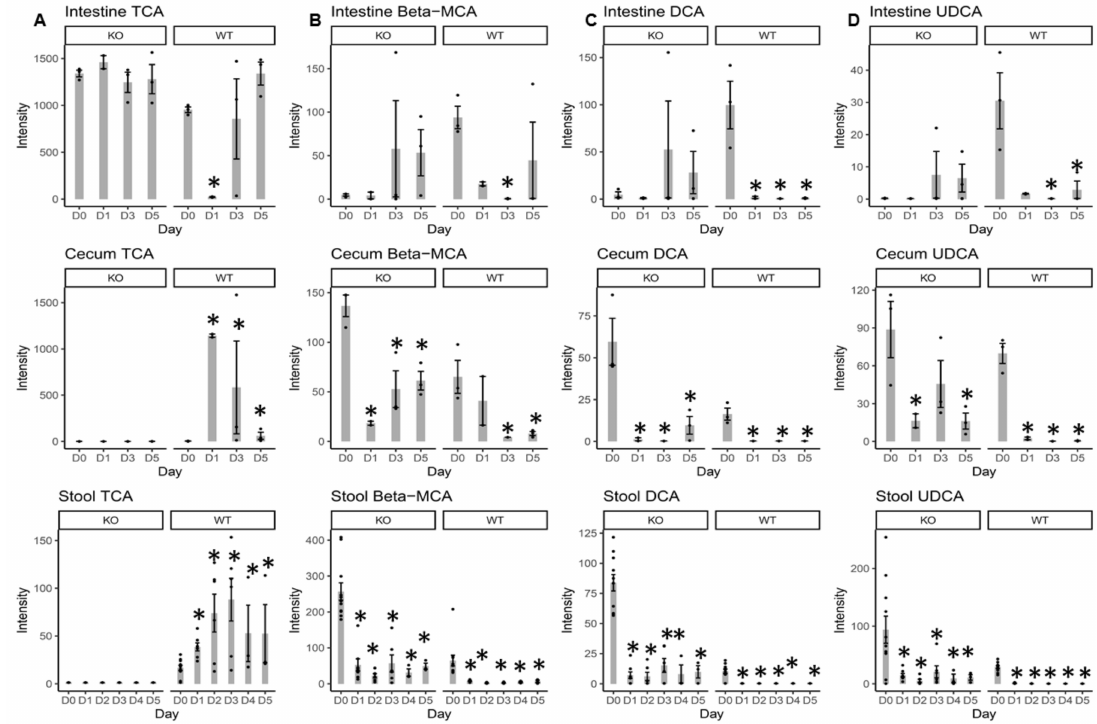
Figure 3. Bar plots of the intensity of primary bile acids (BAs) including taurocholic acid (TCA) ( A ), β -muricholic acid ( β MCA) ( B ), and secondary BAs including deoxycholate (DCA) ( C ) and ursodeoxycholate (UDCA) ( D ) in the intestinal content, cecal content, and stool samples from both KO and WT mice. D0 = day 0 (prior to Cef treatment); D1, D2, D3, D4 and D5 = 1, 2, 3, 4, or 5